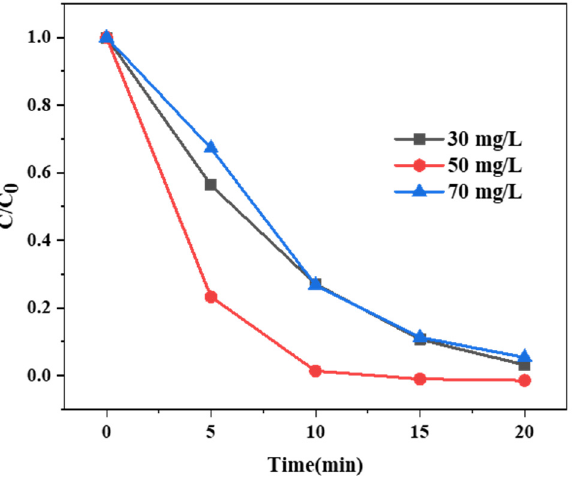
Figure 5. Effect of initial OG concentration on OG degradation. Condition: [PMS] = 3 mM, [ZVC] = 0.3 g/L.